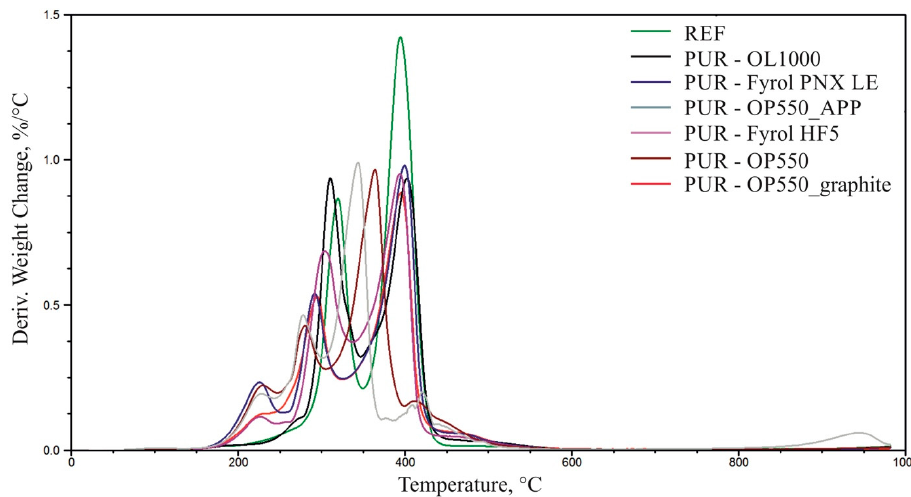
Figure 8. Summary of weight change curves for the foams.